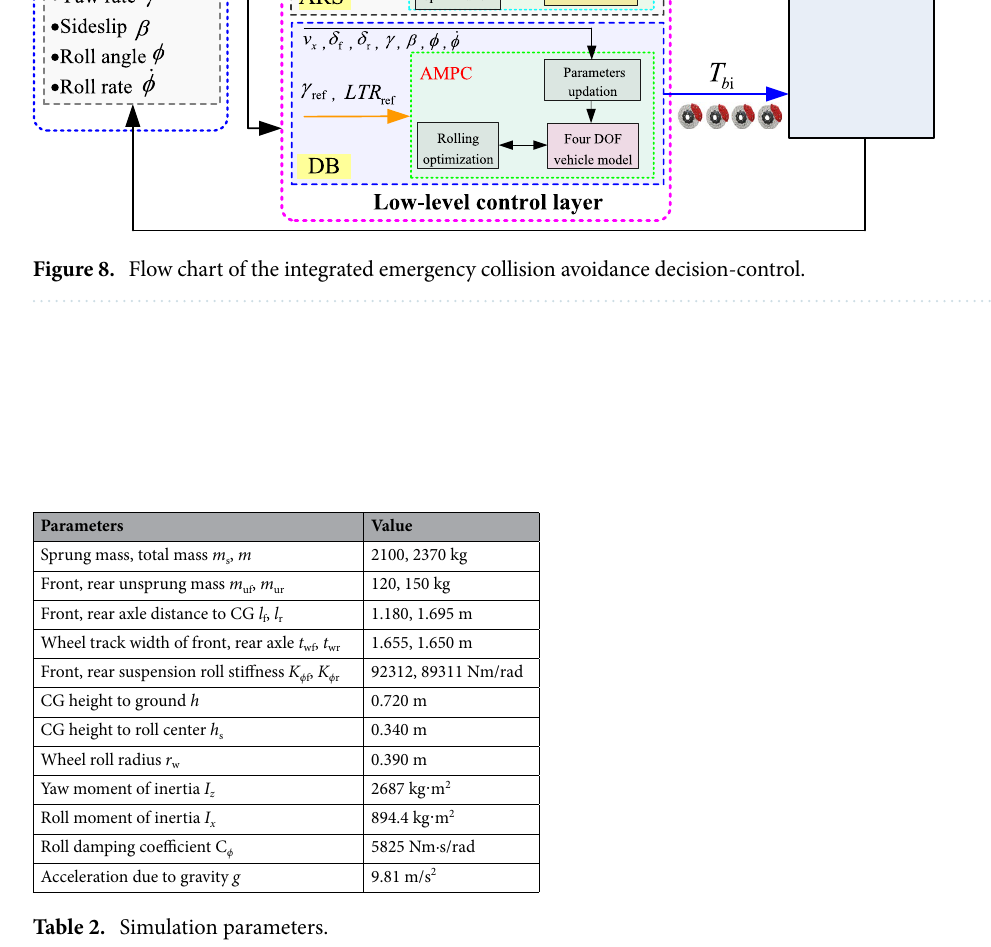
Table 2. Simulation